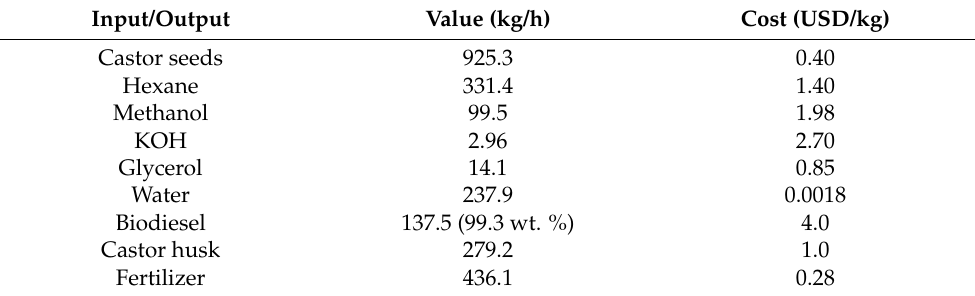
Table 4. Input and outputs flow rates from the biorefinery of castor seeds.